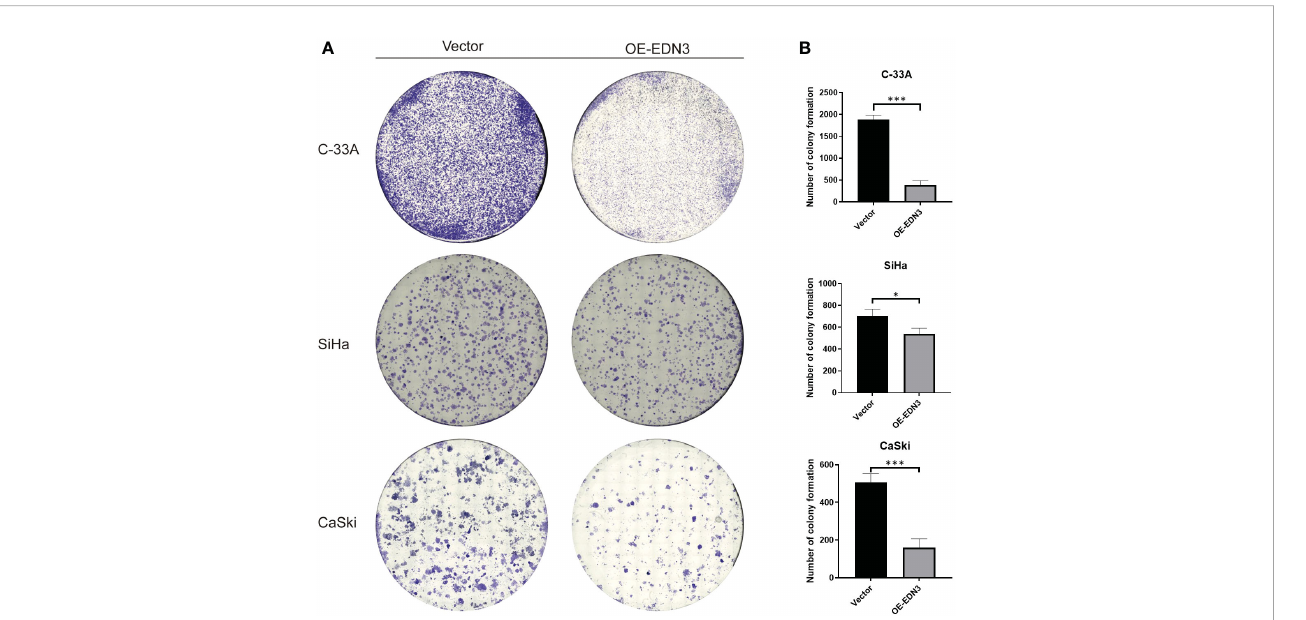
FIGURE 4 Overexpression of EDN3 inhibited the clone formation of C-33A, SiHa and CaSki cells. (A) Representative images of clone formation assay using C-33A, SiHa and CaSki cells transfected with OE- EDN3 or vector. (B) Quanti fi cation of clone formation assay is shown. Values are mean ± SD, N = 3; *P<0.05; ***P<0.001.